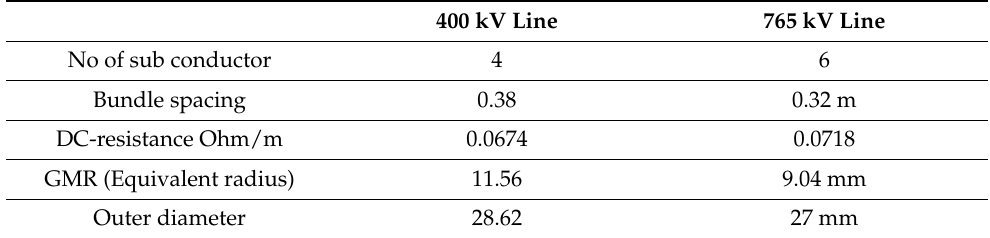
Table A4. AC transmission line